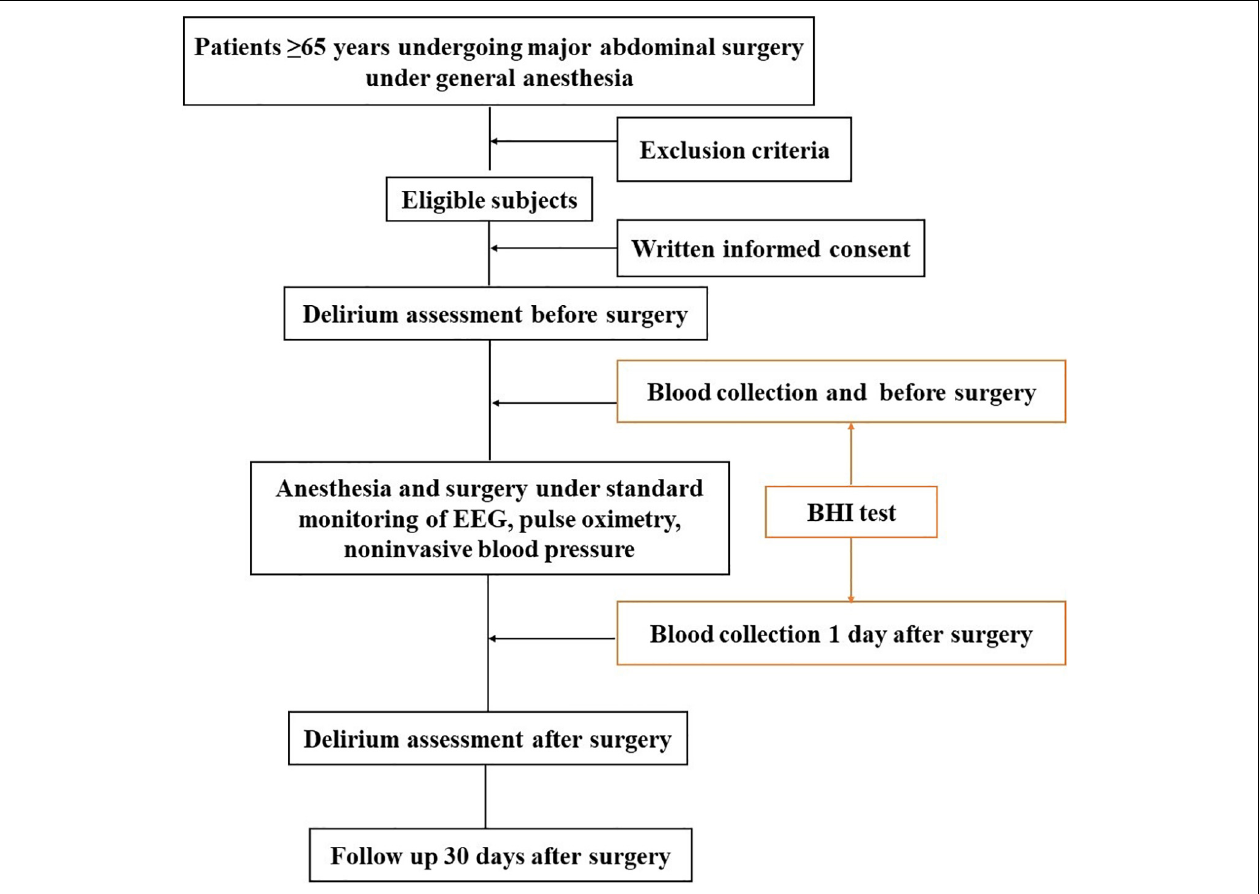
FIGURE 1 | Flowchart of the